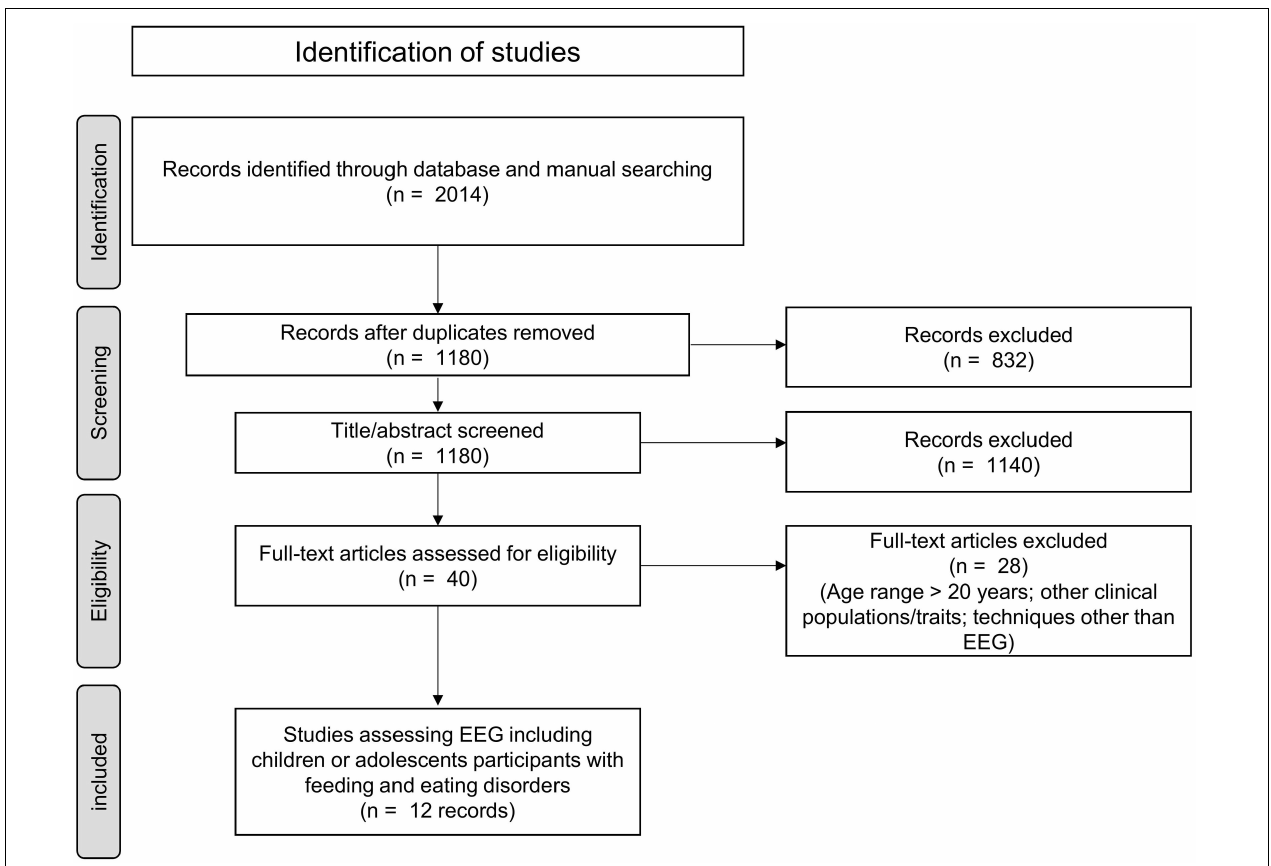
FIGURE 1 | PRISMA flow chart for study